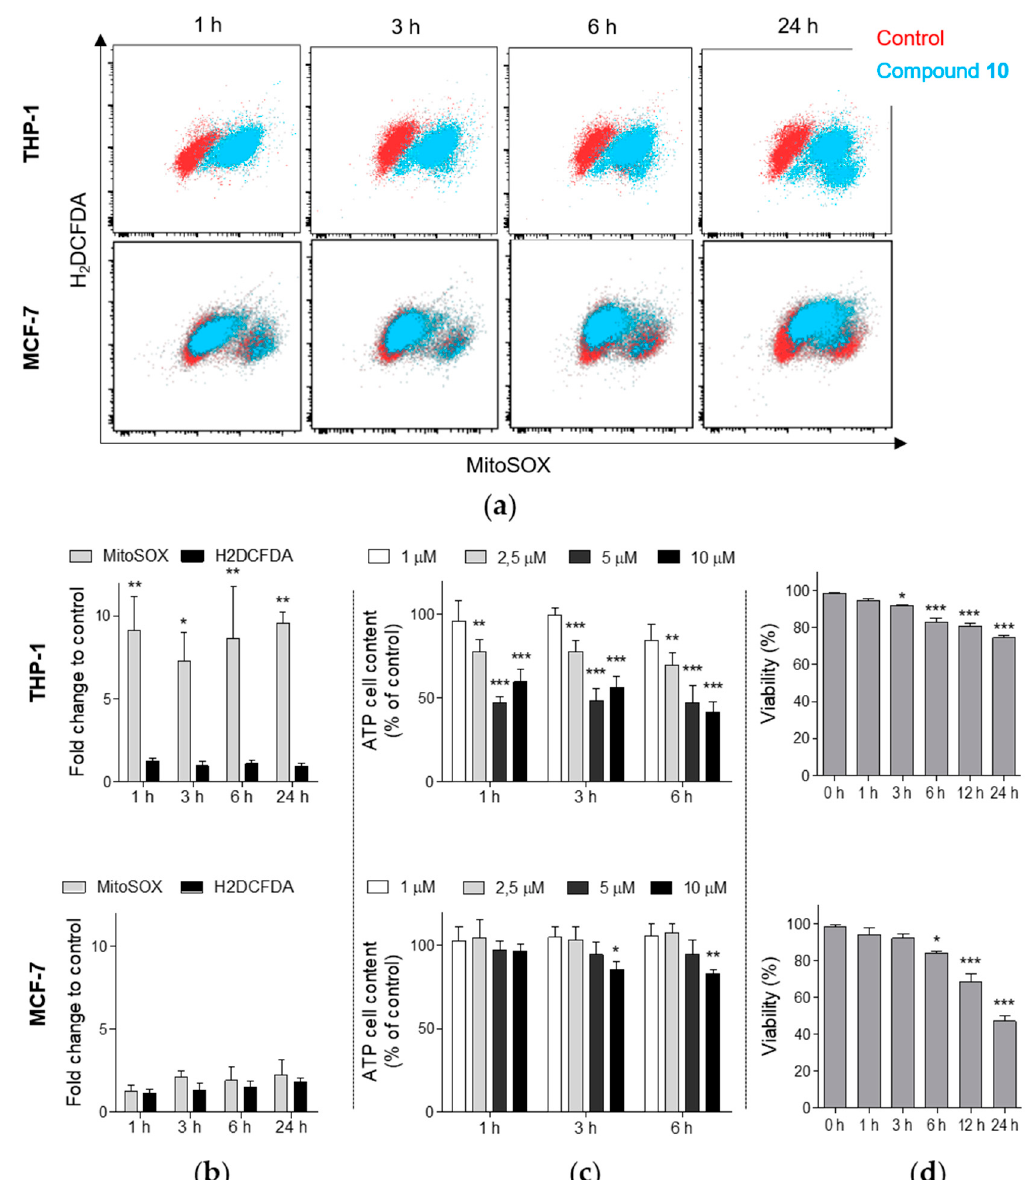
Figure 4. Compound 10 treatment results in loss of ATP cellular content and generation of mitochondrial superoxide in THP-1 cells. THP-1 and MCF-7 cells were treated with compound 10 (10 µ M) if not stated otherwise for indicated time points. ( a , b ) THP-1 and MCF-7 cells were stained with MitoSOX Red or H 2 DCFDA and analyzed by flow cytometry. Dot plots from representative analysis are shown in panel A. ( c ) ATP cellular content was analyzed using luminescent assay. ( d ) Cell viability was determined by erythrosin B exclusion test at indicated time points. The results are shown as the mean ± SD from at least three independent experiments. * p < 0.05 ** p < 0.01, *** p < 0.001, significantly di ff erent from drug-free control ( b , c ) or 0 h ( d ).